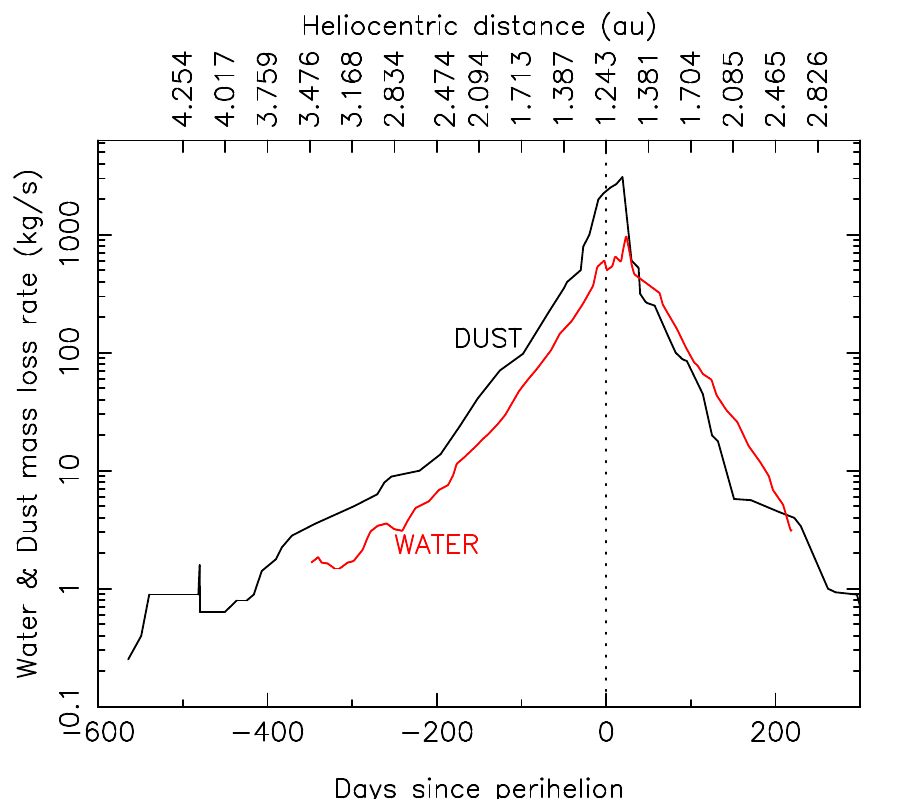
Figure 5. Modeled dust loss rate (black line) and water production rate (red line) from the ROSINA instrument on board Rosetta [73], as a function of the heliocentric distance. The sudden increase in dust loss rate at 470 d pre-perihelion (4.11 au) for the modeled dust loss rate corresponds to the outburst observed by the OSIRIS camera on 30 April 2014 [42,74]. Adapted from